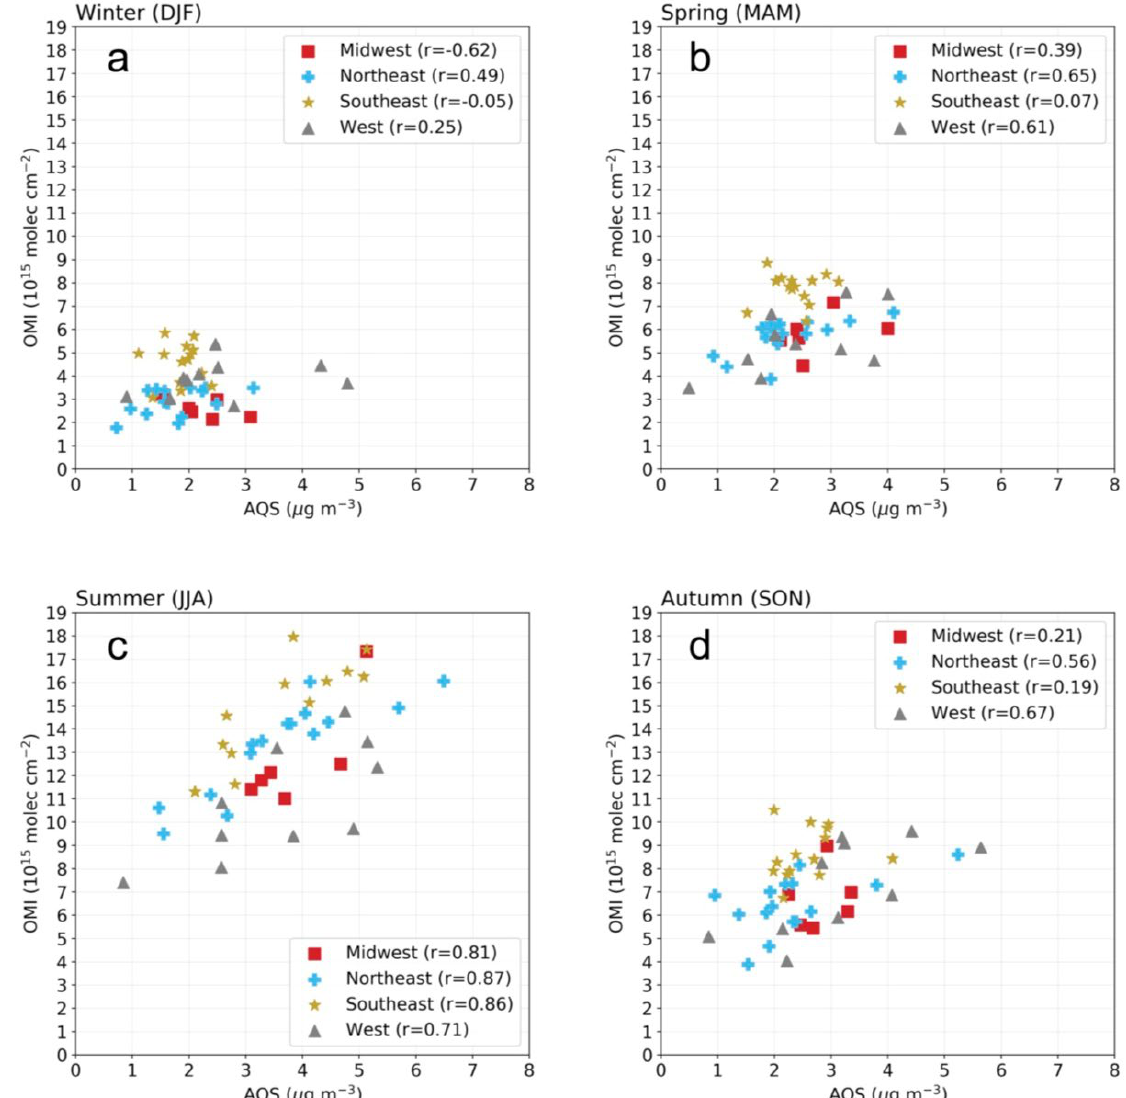
Figure 3. Spatial correlation of 2007–2015 average HCHO from 45 AQS sites ( x -axis) and coincident OMI pixels ( y -axis). Each point represents a single site, with OMI and AQS values averaged over the season. Points are color coded to reflect their region, and spatial correlation coefficient r values in different regions are shown in the legend. Each panel represents average values for: ( a ) winter, ( b ) spring, ( c ) summer, and ( d ) autumn.